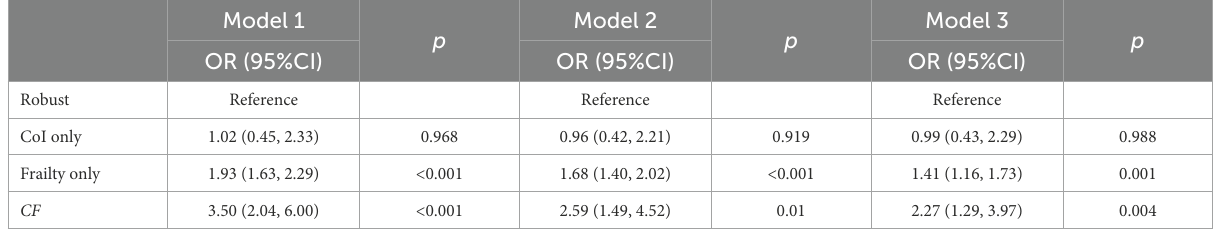
TABLE 3 Associations between cognitive and/or frailty status with